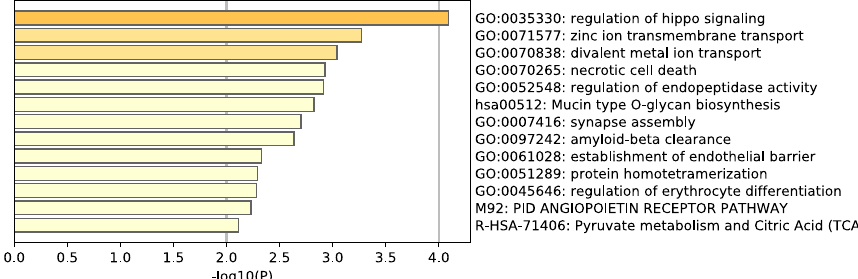
Fig. 7 Top 13 signi fi cantly different pathways between responders and nonresponders in pretreatment